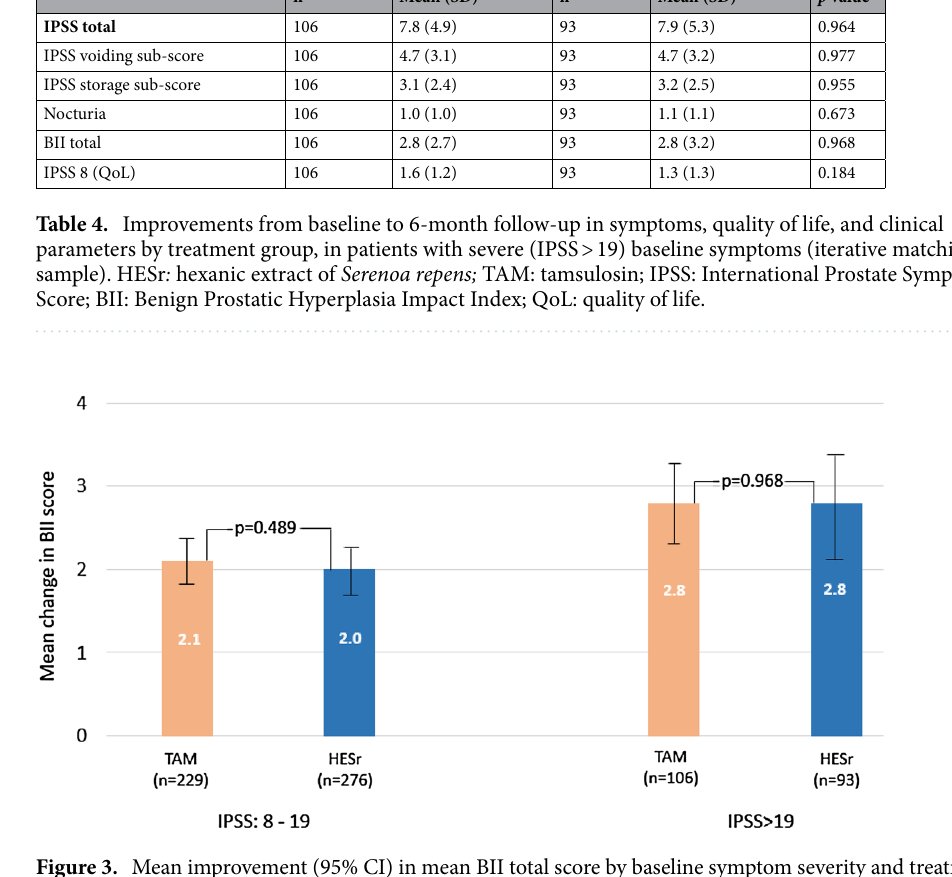
Figure 3. Mean improvement (95% CI) in mean BII total score by baseline symptom severity and treatment group, baseline to 6 months (iterative matching sample). TAM: tamsulosin; HESr: hexanic extract of Serenoa repens; BII: Benign Prostatic Hyperplasia Impact Index; IPSS: International Prostate Symptom